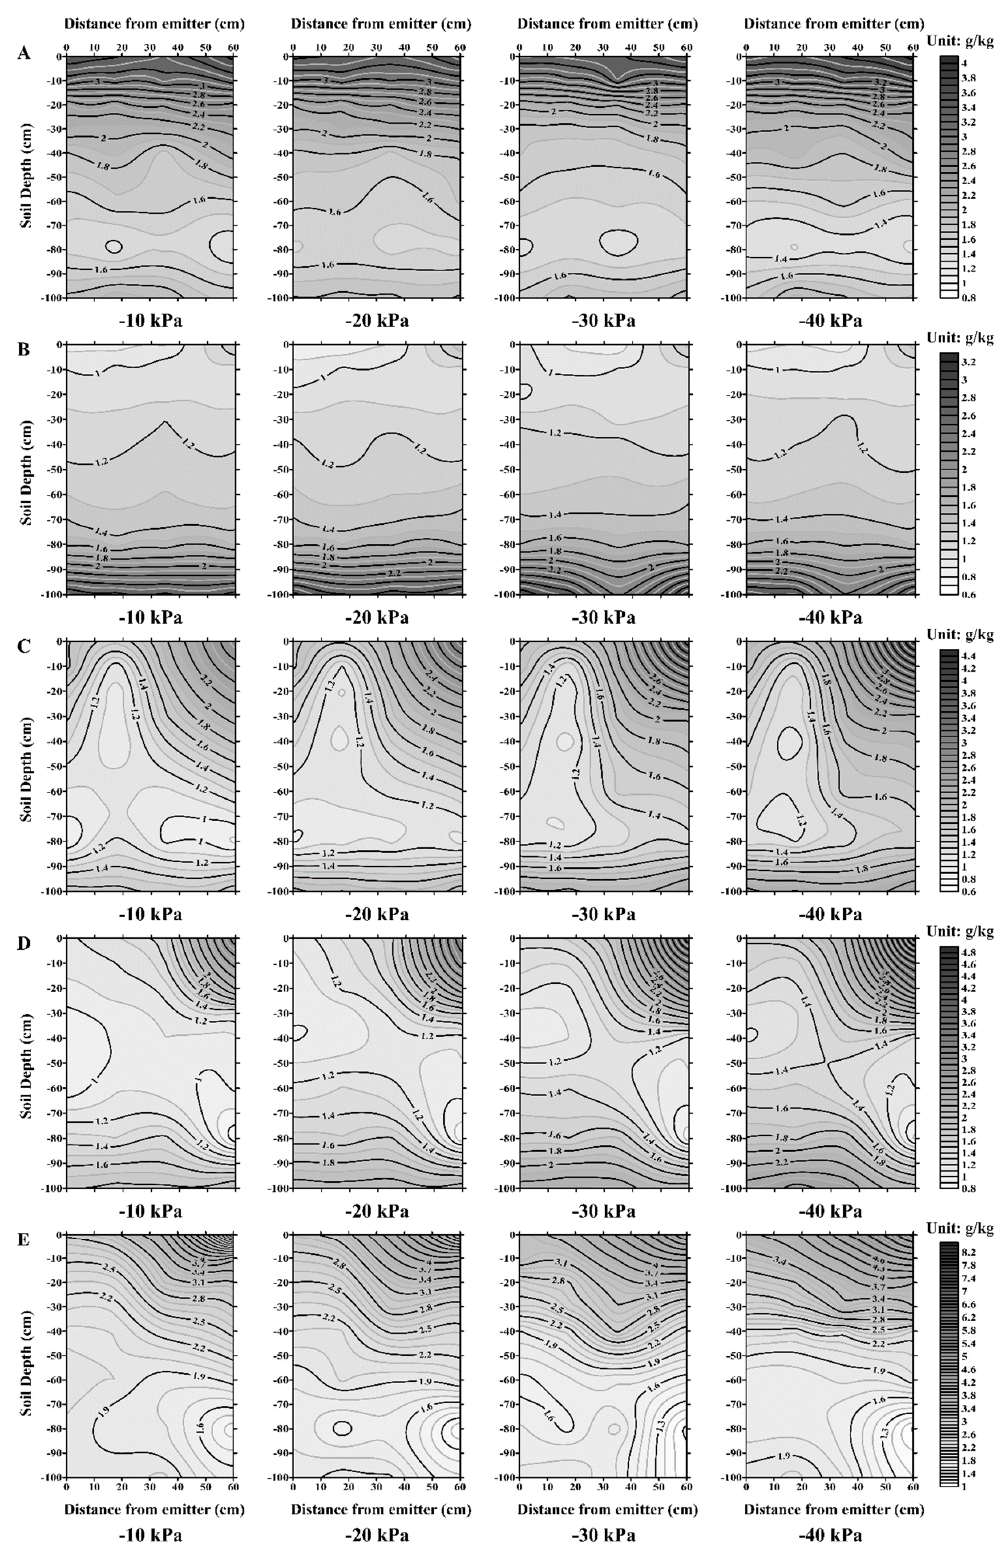
Figure 9. Spatial distribution of soil salt (g · kg − 1 ) along the vertical transect that is perpendicular to the drip line ( A ) before spring irrigation, ( B ) before sowing, ( C ) before the irrigation at the jointing stage, ( D ) after the irrigation at the jointing stage, and ( E ) after harvest, for all treatments in 2016.